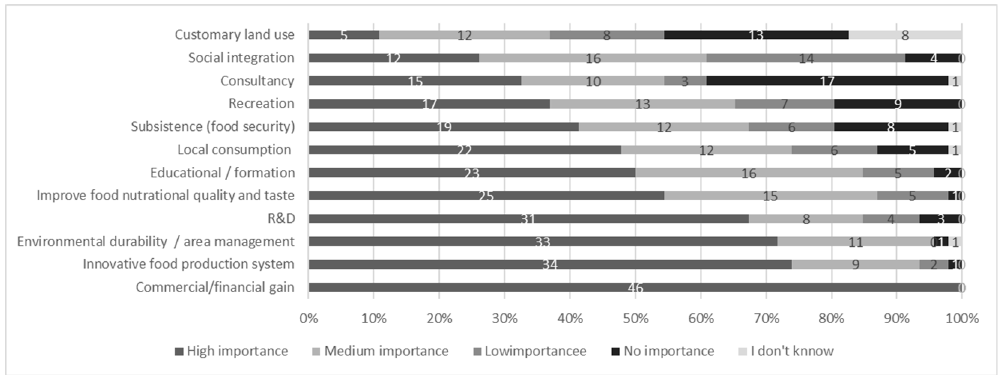
Figure 3. Main purposes of the different entities.